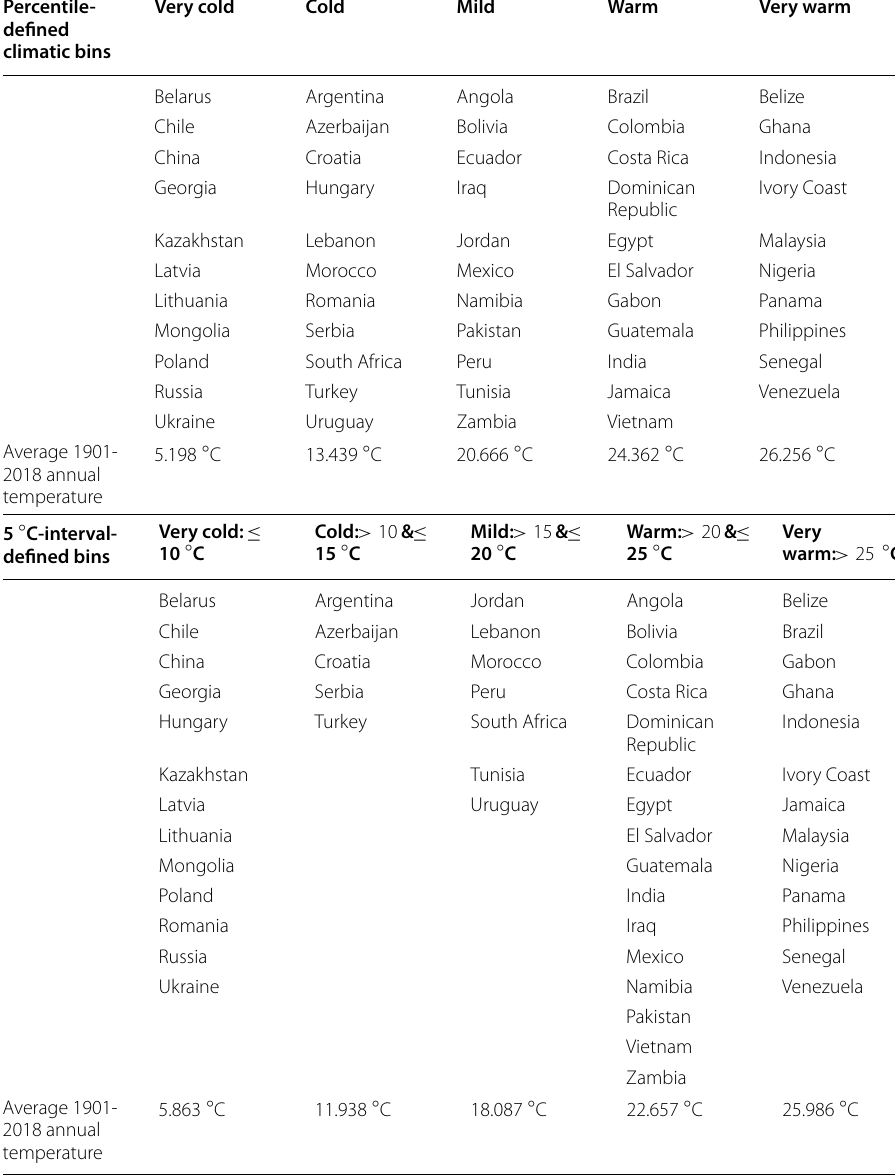
Table 5 Countries in each percentile- or 5 ◦ C-interval-defined climatic bin Percentile- defined climatic